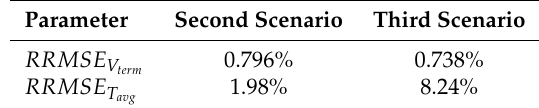
Table 10. Relative root mean square errors (RRMSEs) for the lumped battery pack model